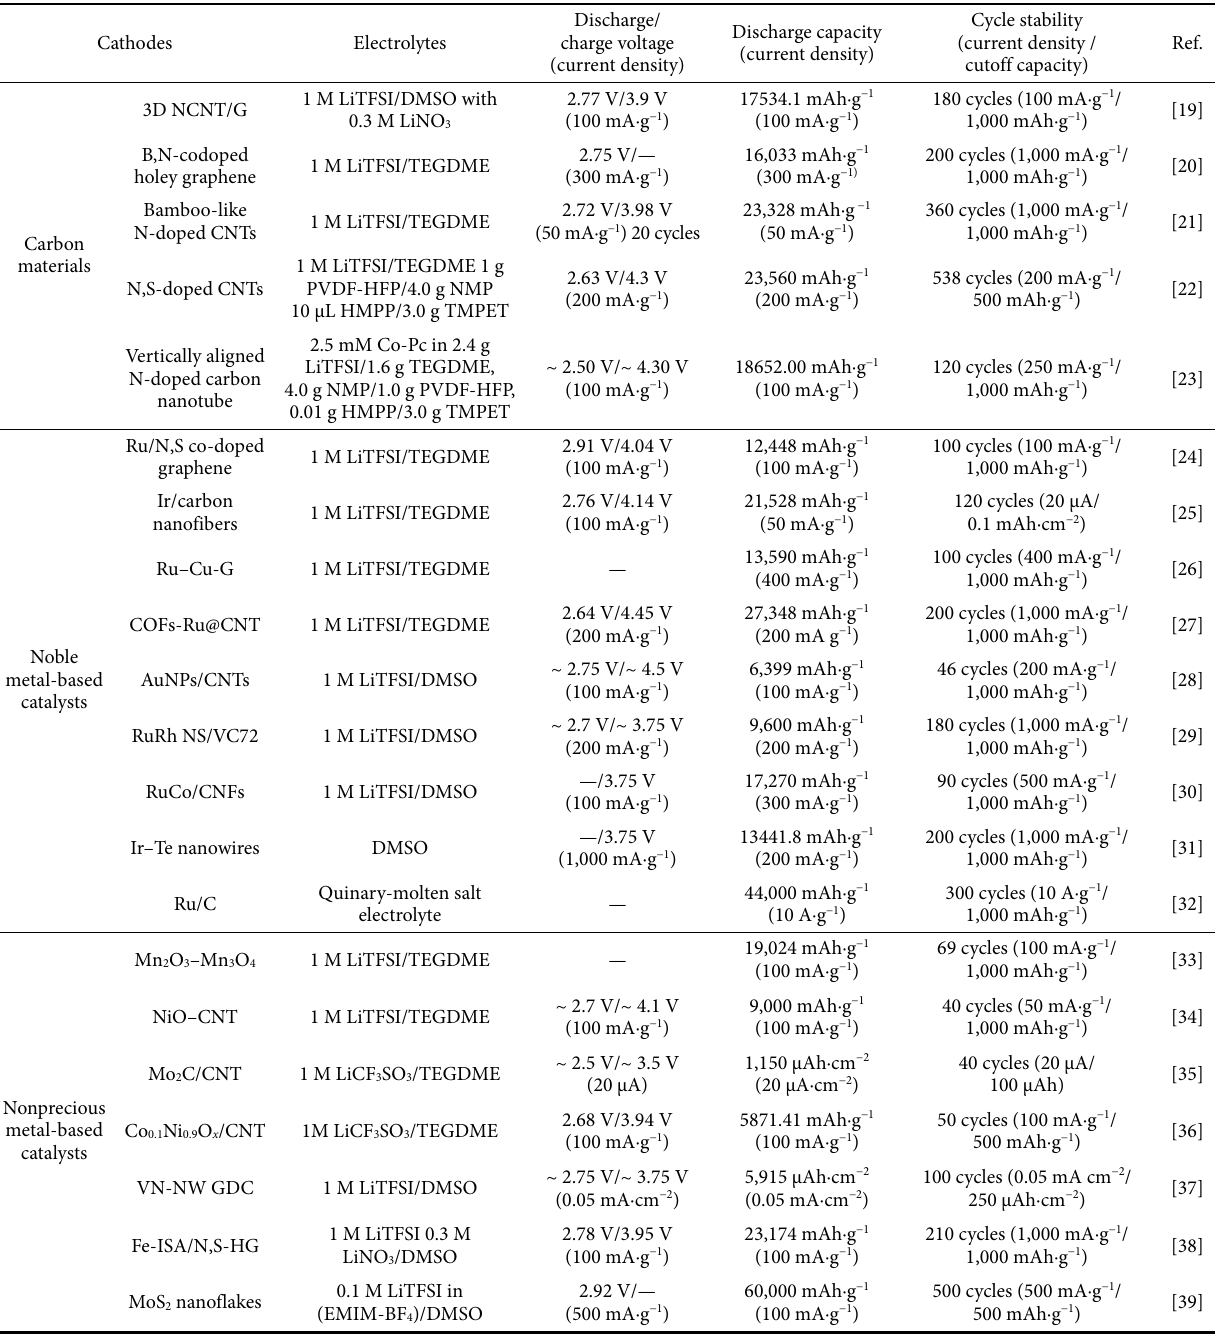
Table 1 The performance of various cathodes and electrolytes in nonaqueous Li–CO 2 battery Cathodes